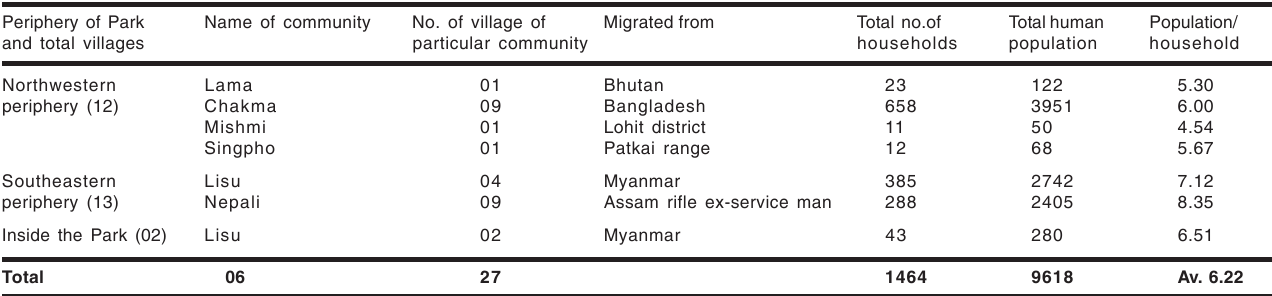
Table 1. Human profile of dependent villages in and around Namdapha National Park (Arunachalam et al. 2004)